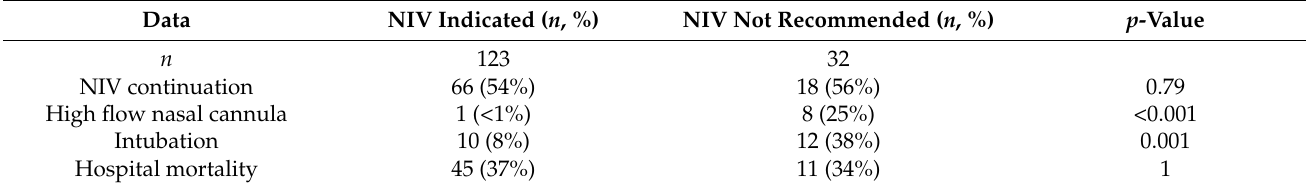
Table 4. Outcome of the patients with NIV indicated and not recommended according to the